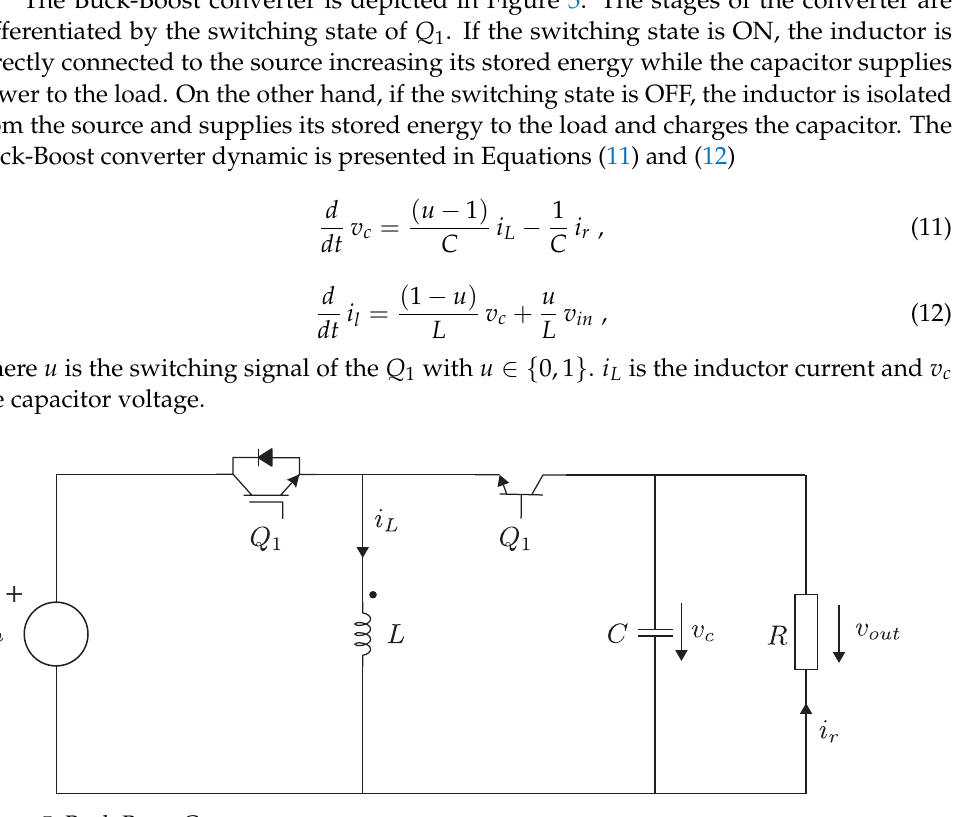
Figure 5. Buck-Boost